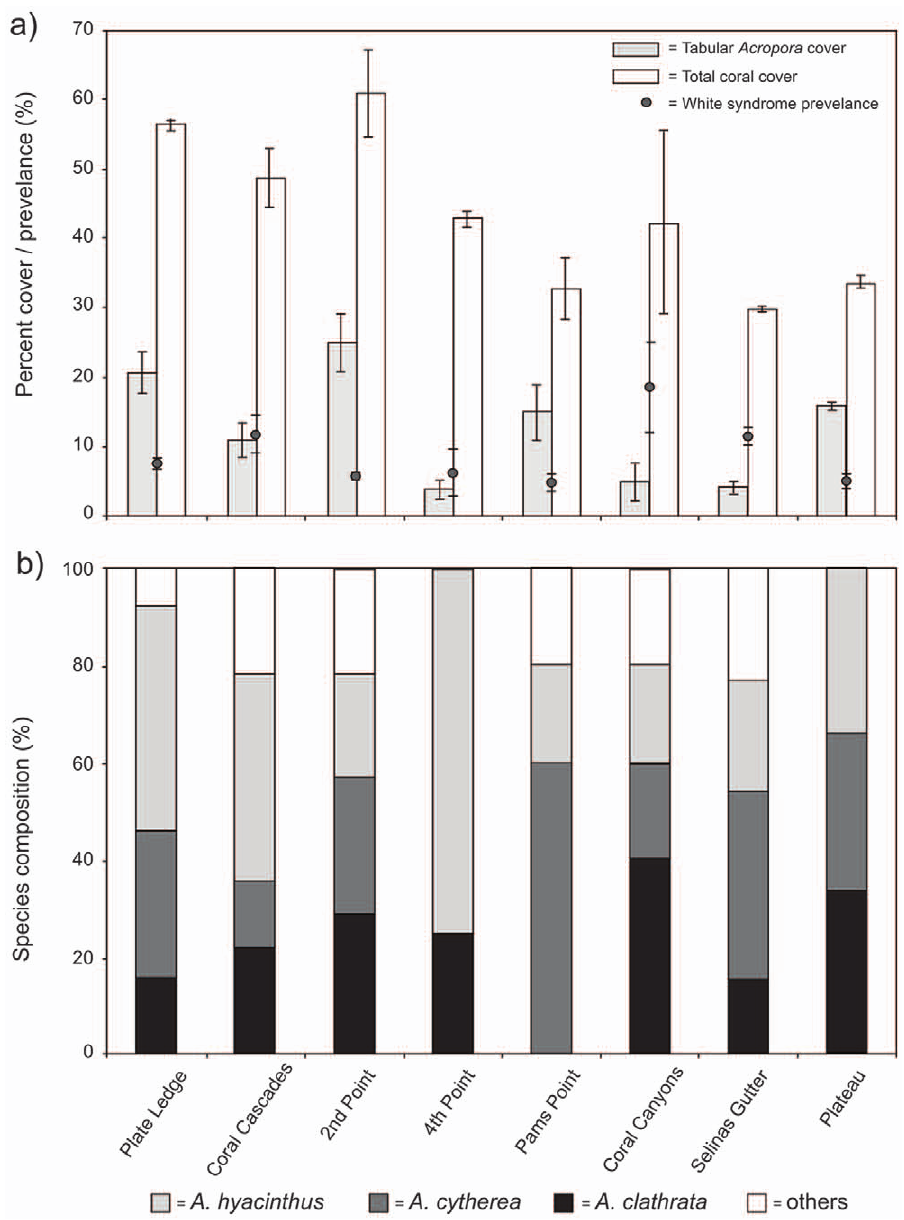
Figure 3. Coral community structure and Acroporid white syndrome prevalence at sites around Heron Reef: a) Coral cover and prevelance ( 6 standard error), b) Species composition of tabular Acropora spp. affected by white syndrome.